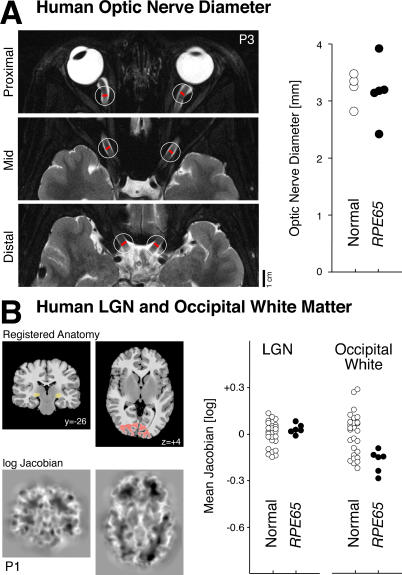
Visual Brain Anatomy in Human LCA from RPE65 Mutations(A) Interpial optic nerve diameter for patients and controls is shown. Left: Locations of optic nerve measurements were made for patient 3 (P3) upon high-resolution T2-weighted images. The average of six measurements (three from each nerve) were obtained for each participant. Right: Average optic nerve diameters for RPE65-LCA patients and controls is shown. No population difference was observed.(B) Whole brain morphometric analysis. Left: The T1-weighted anatomical images from RPE65 patients and controls were warped to a representative template (top row). The (log) determinant of the Jacobian matrix calculated during warping for each participant (bottom row) indexes the degree to which cerebral tissue is smaller or larger than the template image. No differences between patients and controls were present in a whole brain analysis of these measures. A focused analysis was conducted within the LGN and occipital lobe white matter, indicated in yellow and red on the registered anatomy. Also shown is the y- or z-position (mm) of each slice relative to the anterior commissure. Right: The average (log) Jacobian measure within the regions of interest for RPE65-LCA patients and controls is shown. Measures were slightly, but significantly, smaller for patients within occipital white matter, indicating relative atrophy.